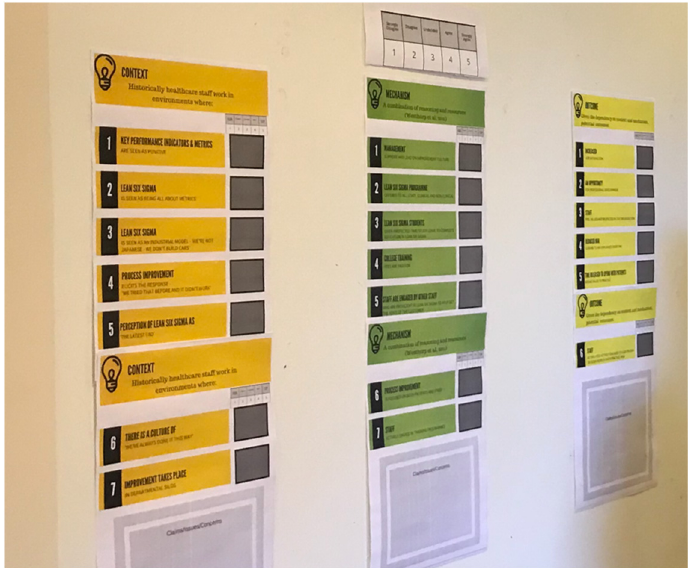
Figure 2. An example of display boards for workshops (source authors).